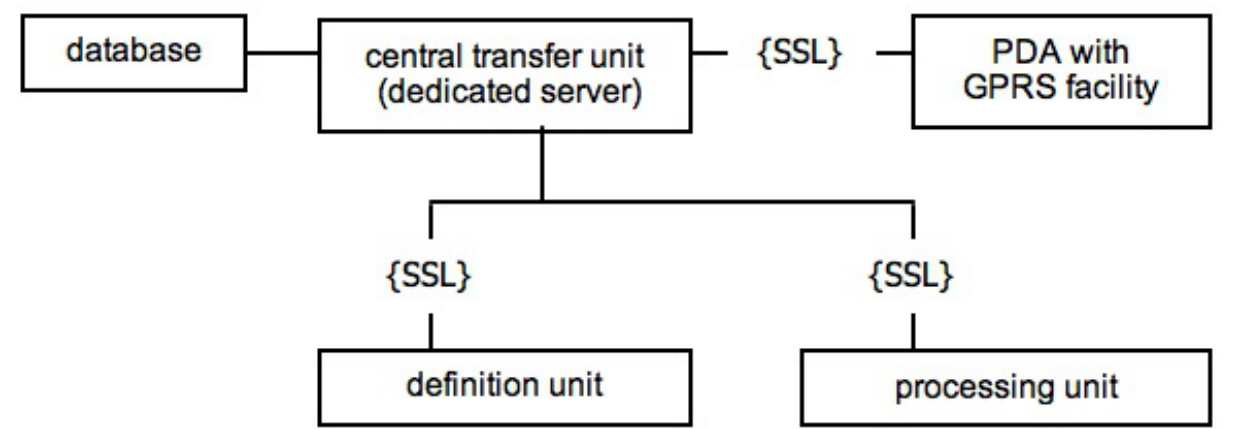
Figure 1. Design of software application ODA